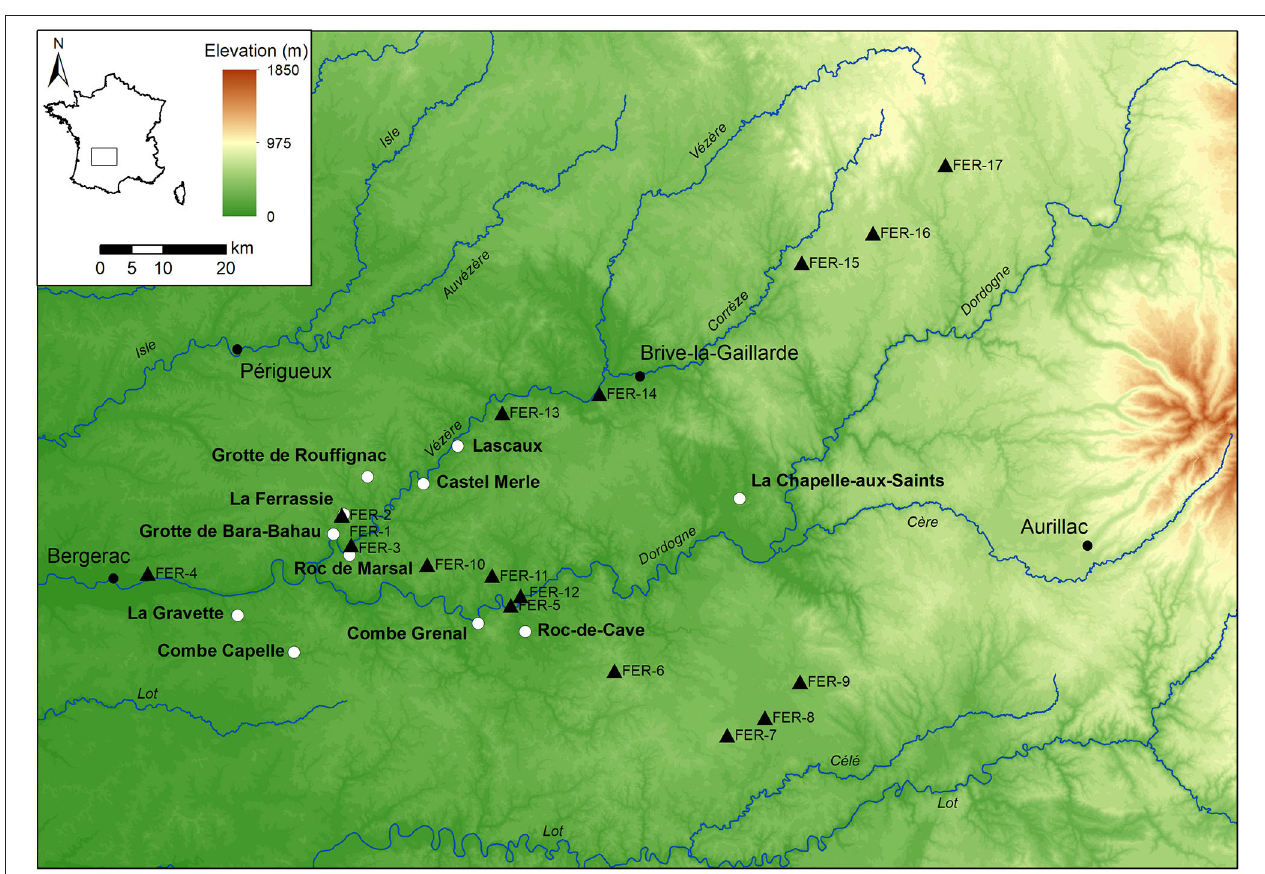
FIGURE 1 | Elevational map of the study area with the sampling locations (black triangles), and the location of selected Middle and Upper Paleolithic archaeological sites (white